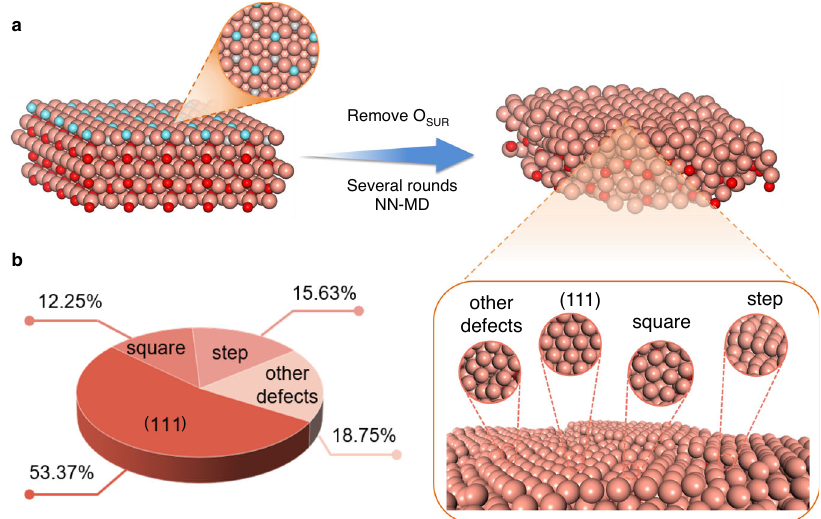
Fig. 1 Theoretical simulation of oxide-derived process. a Illustration of our procedure to construct OD-Cu model with molecular dynamic simulation. Color code: brown-Cu; blue-surface O; gray-subsurface O; red-bulk O. b Proportions of different surface